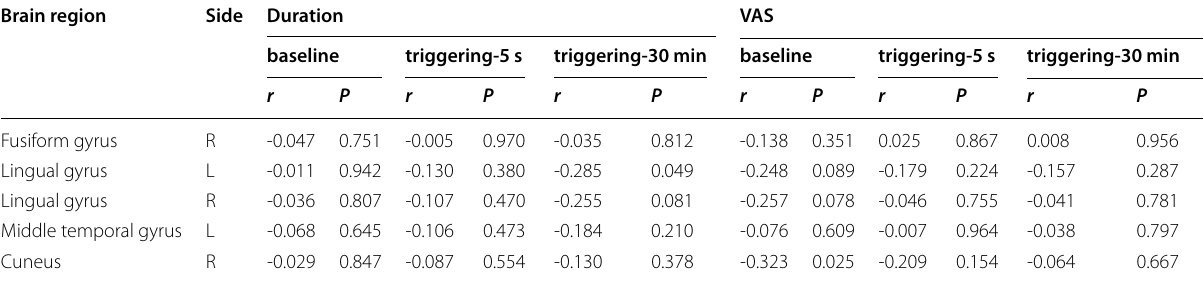
Table 5 The correlation between the different brain regions in sALFF and the VAS, duration among different times after triggering the pain in patients with